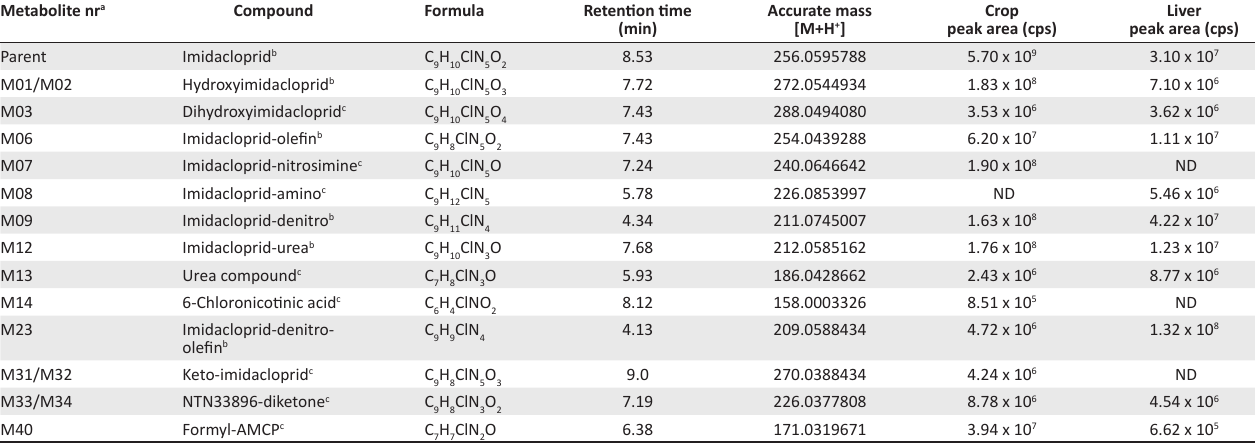
TABLE 2: Imidacloprid and its metabolites detected by liquid chromatography–high-resolution mass spectrometry in the crop contents and liver samples collected from Cape spurfowl that died in the Western Cape. Metabolite nr a Compound Formula Retention time